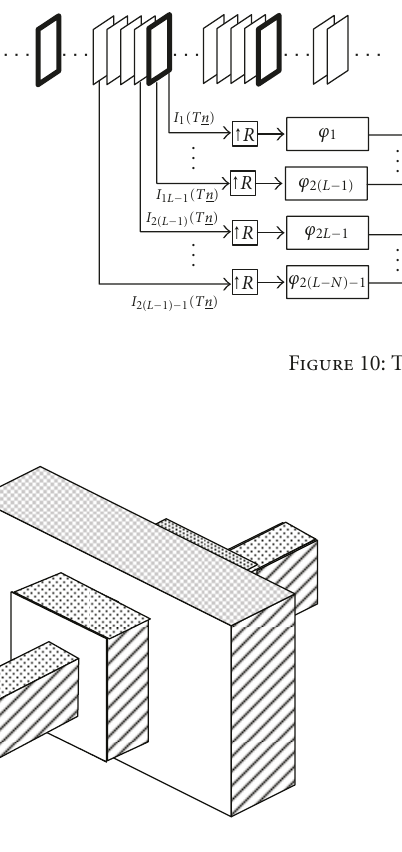
Figure 11: Alternative spectral covering set.